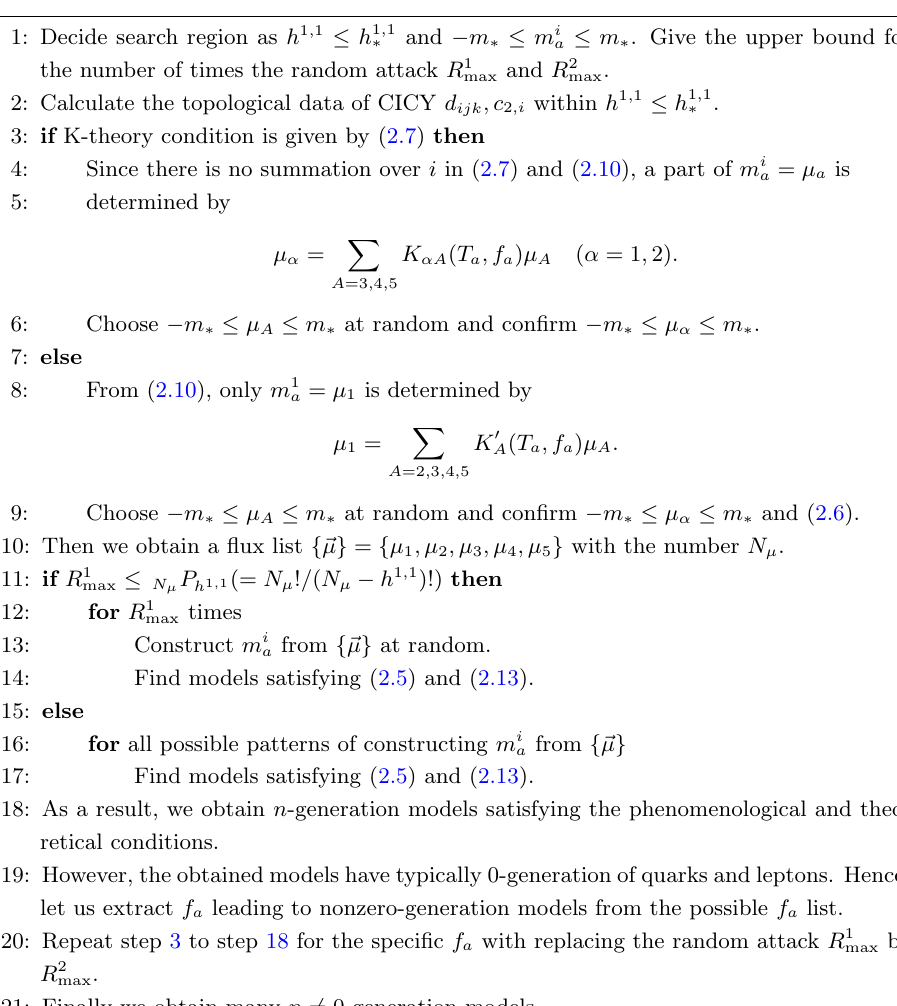
Algorithm 1 . Brute force